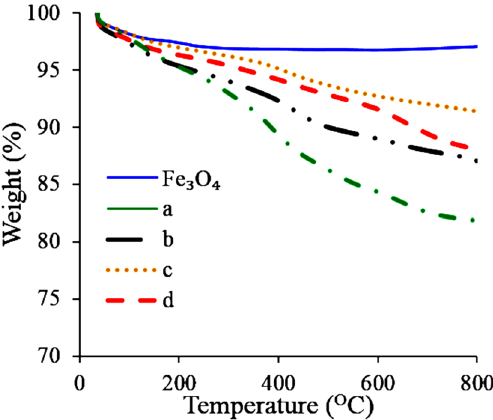
Figure 4. TGA results of neat Fe 3 O 4 nanoparticles; ( a ) neat3D-rGO; ( b ) Th-rGO/Fe 3 O 4 /PVP; ( c ) Ch-rGO/ Fe 3 O 4 ; and ( d ) Th-rGO/Fe 3 O 4 .